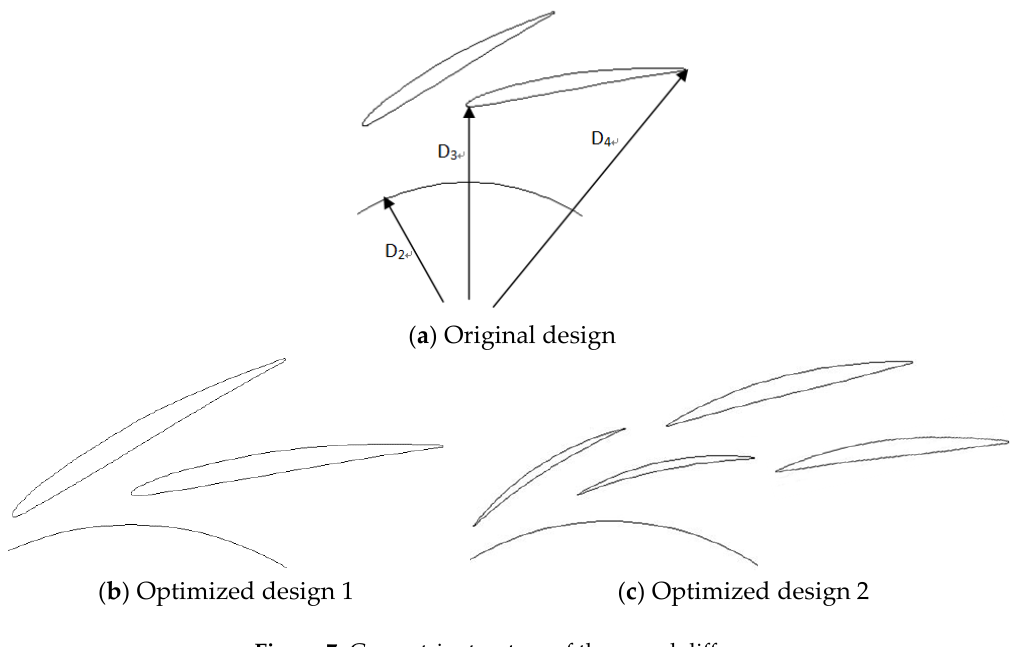
Figure 7. Geometric structure of the vaned diffuser. Table 2. Ratio of design A d * / A i * to theoretical A d * / A i * .